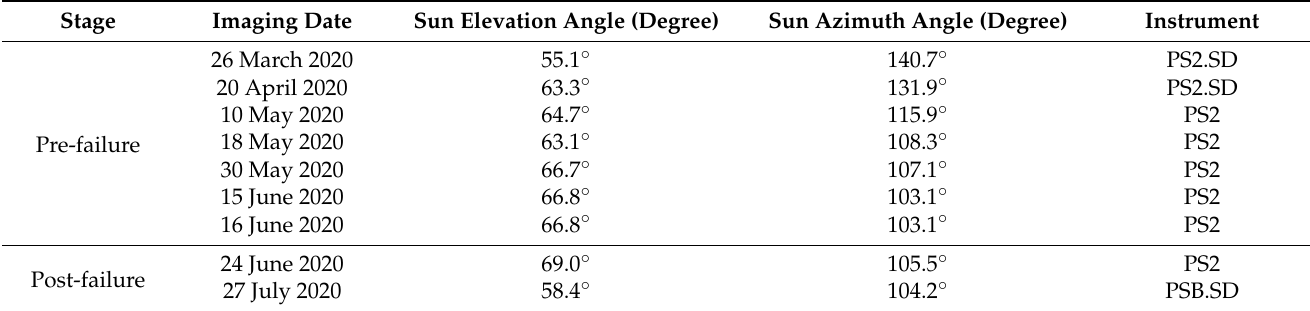
Table 1. Optical images acquired by the PlanetScope satellite for this study.